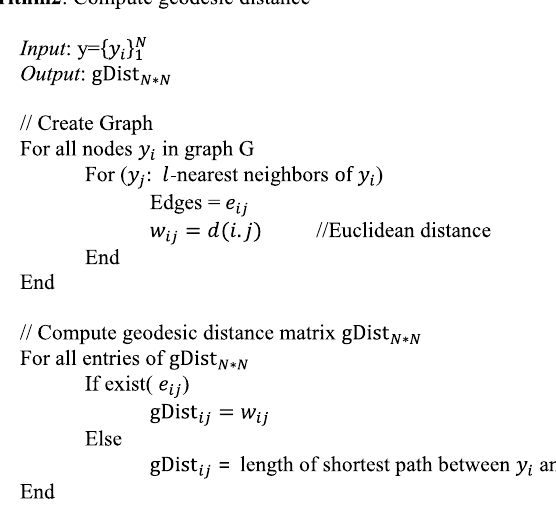
Algorithm 3 consists of two main steps: (1) define prototype set (2) construct dissimi- larity